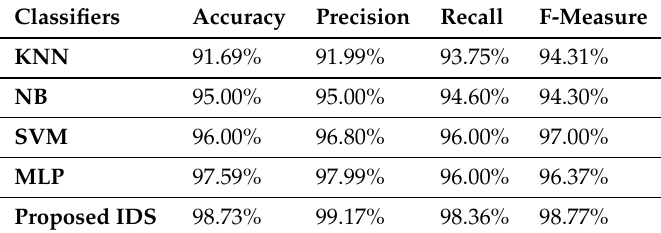
Table 9. Comparison of Classifiers